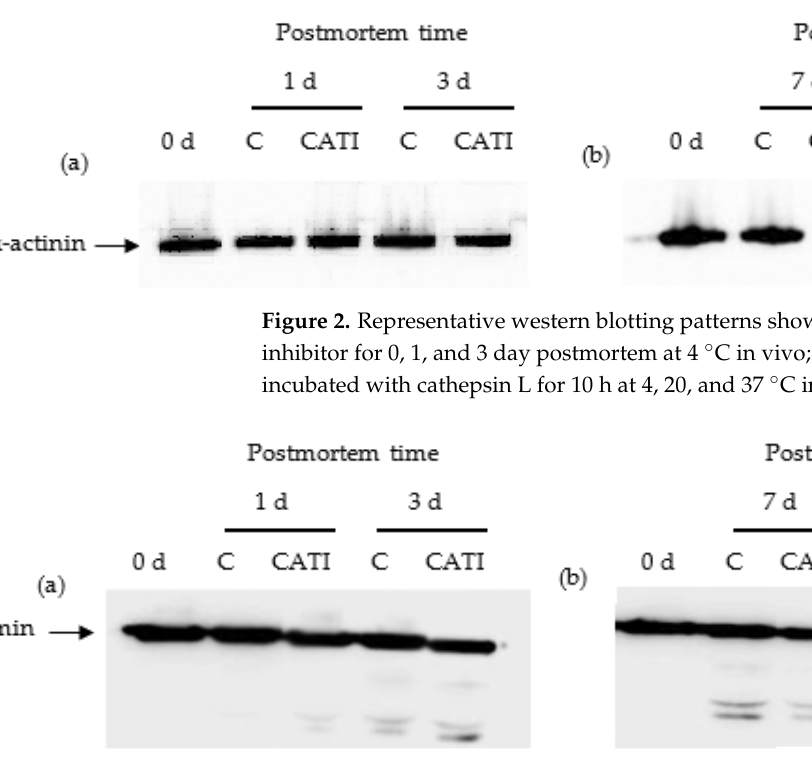
Figure 3. Representative western blotting patterns showing the degradation of desmin by cathepsin L in vivo and in vitro. ( a ) Samples treated with cathepsin L inhibitor for 0, 1, and 3 day postmortem at 4 °C in vivo; ( b ) samples treated with cathepsin L inhibitor for 0, 7, and 14 day postmortem at 4 °C in vivo; ( c ) samples incubated with cathepsin L for 10 h at 4, 20, and 37 °C in vitro.